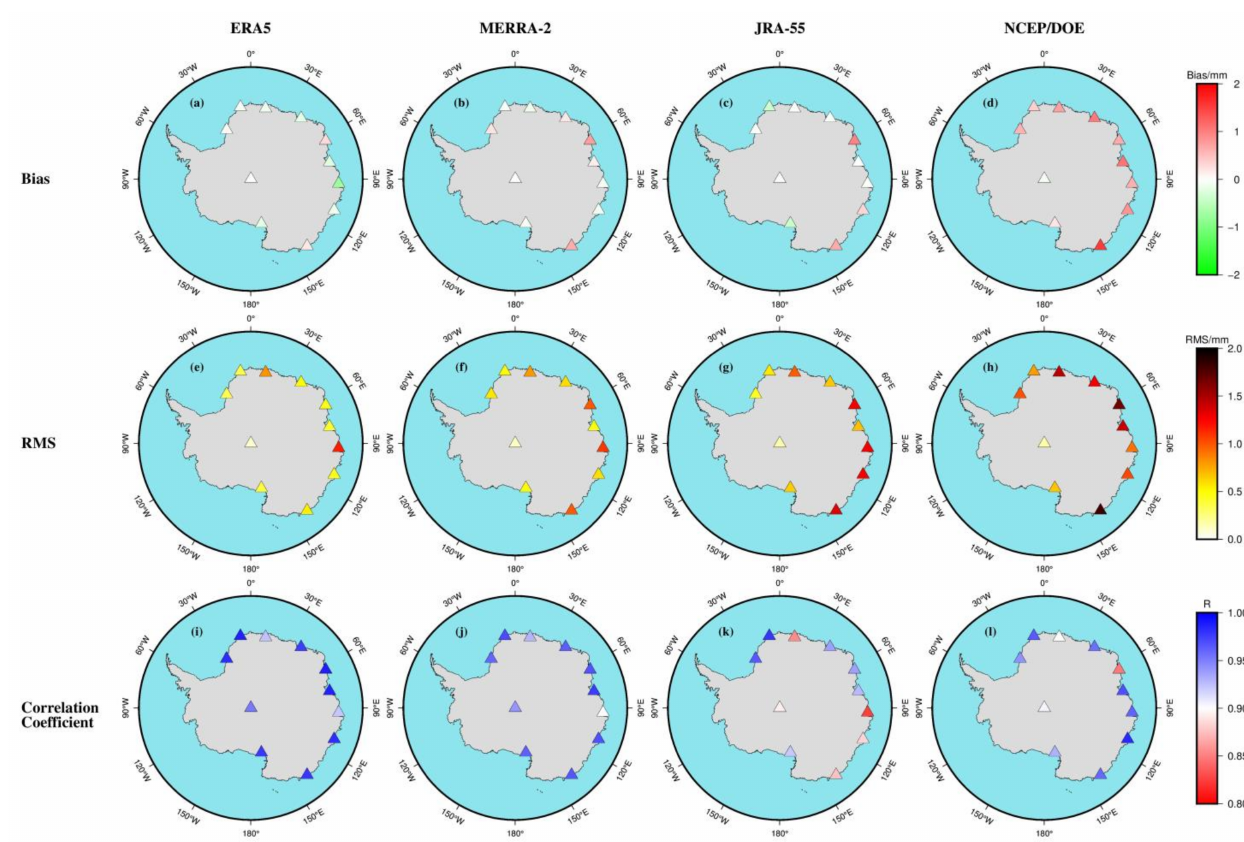
Figure 5. Spatial distributions of the (top) bias, (middle) RMS and (bottom) correlation coefficient of the PWV between ( a , e , i ) ERA5 and radiosonde, ( b , f , j ) MERRA-2 and radiosonde, ( c , g , k ) JRA-55 and radiosonde and ( d , h , l ) NCEP/DOE and radiosonde in Antarctica from 2001 to